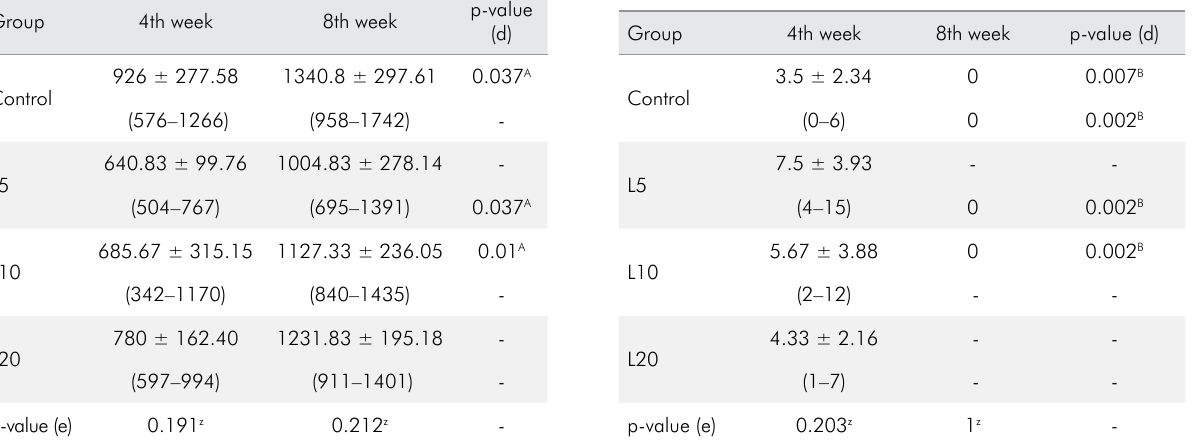
Table 3. Analysis of osteoclast number among groups and dependent on time. Data presented as mean ± standard deviation (minimum–maximum).